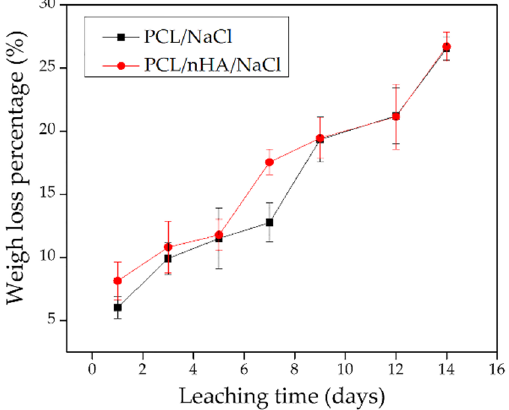
Figure 7. Weight loss percentage versus leaching time in PCL/NaCl (black line) and PCL/nHA/NaCl (red line) scaffolds.